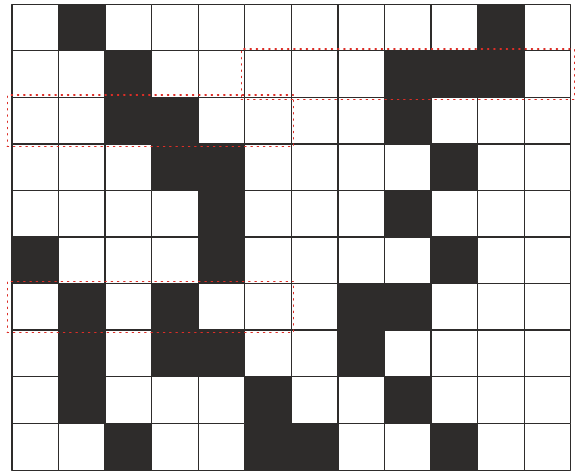
Figure 3: A scratching simulated diagram.